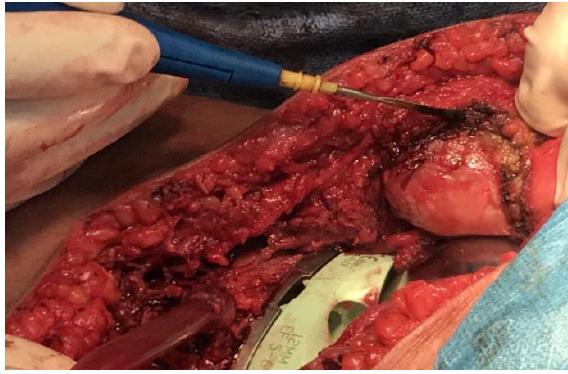
Figure (2): Total knee arthroplasty with patellar denervation Results: Among 35 patients enrolled in this study, 21 were females and only 14 were males, their age groups were shown in table (1). The female to male ratio was (1.5: 1), and the mean class interval was about (62.8) years.